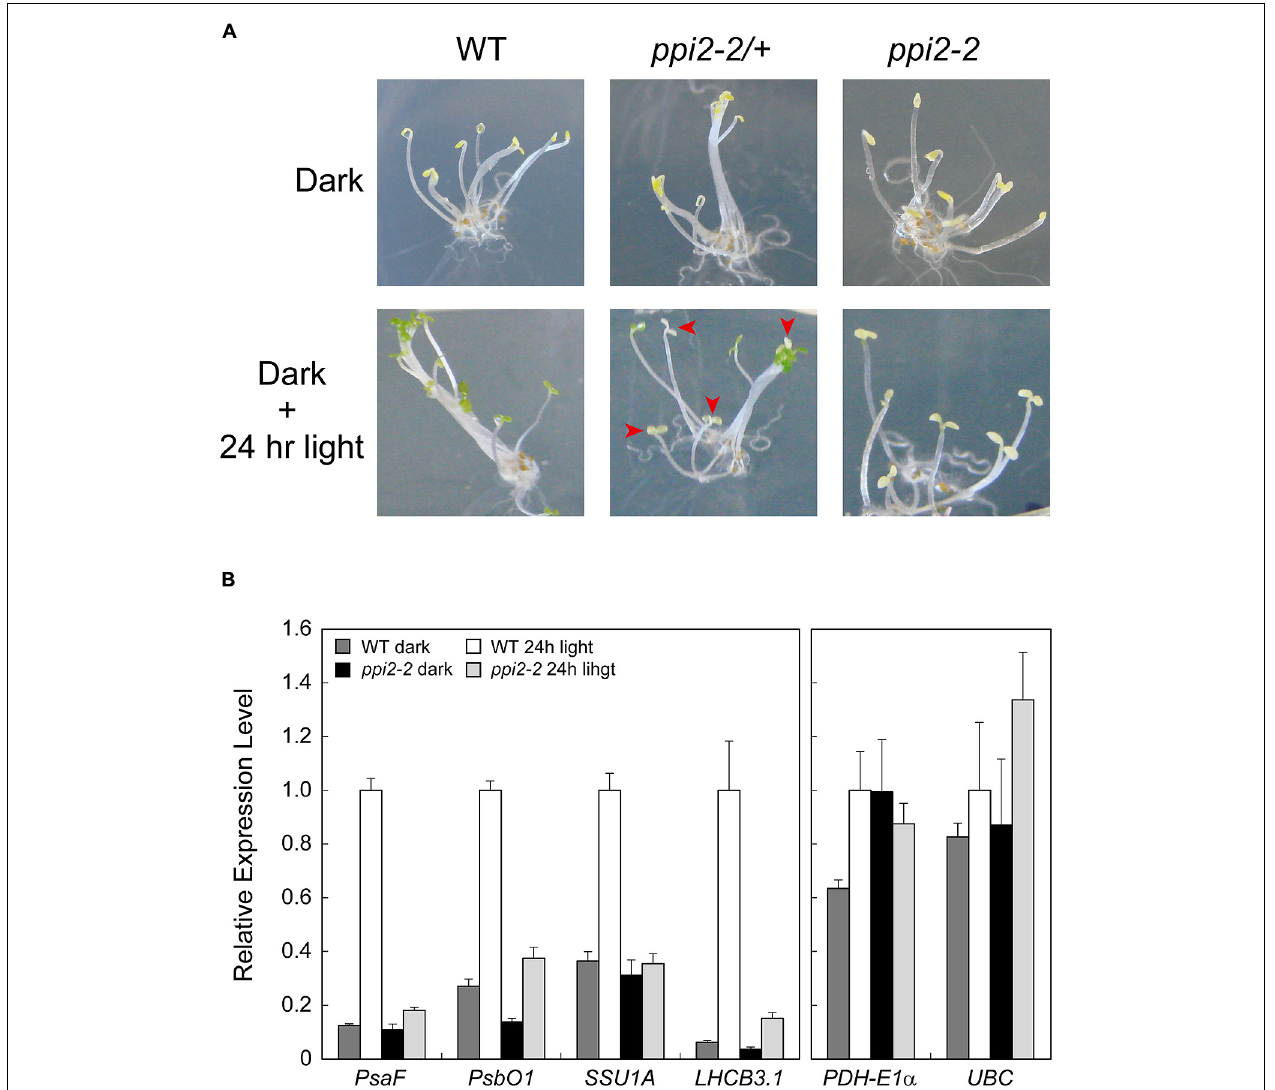
FIGURE 4 |The light response of seedlings germinated from wild-type (WT), heterozygous ppi2-2 ( ppi2-2/ + ), and homozygous ppi2-2 ( ppi2-2 ) seeds. (A) Phenotype of wild-type, ppi2-2/ + , and ppi2-2 progenies grown in the dark (Dark). The plants were then exposed to continuous white light for 24 hr (Dark + 24 hr light). Arrowheads indicate homozygous ppi2-2 plants found in the ppi2-2/ + progeny.